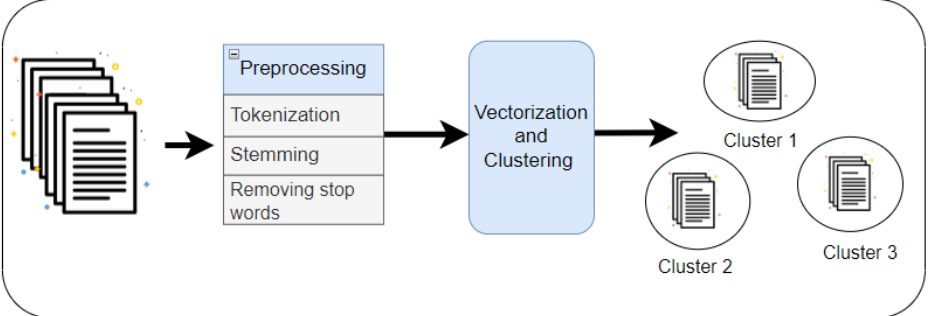
Figure 1. Document clustering phases.